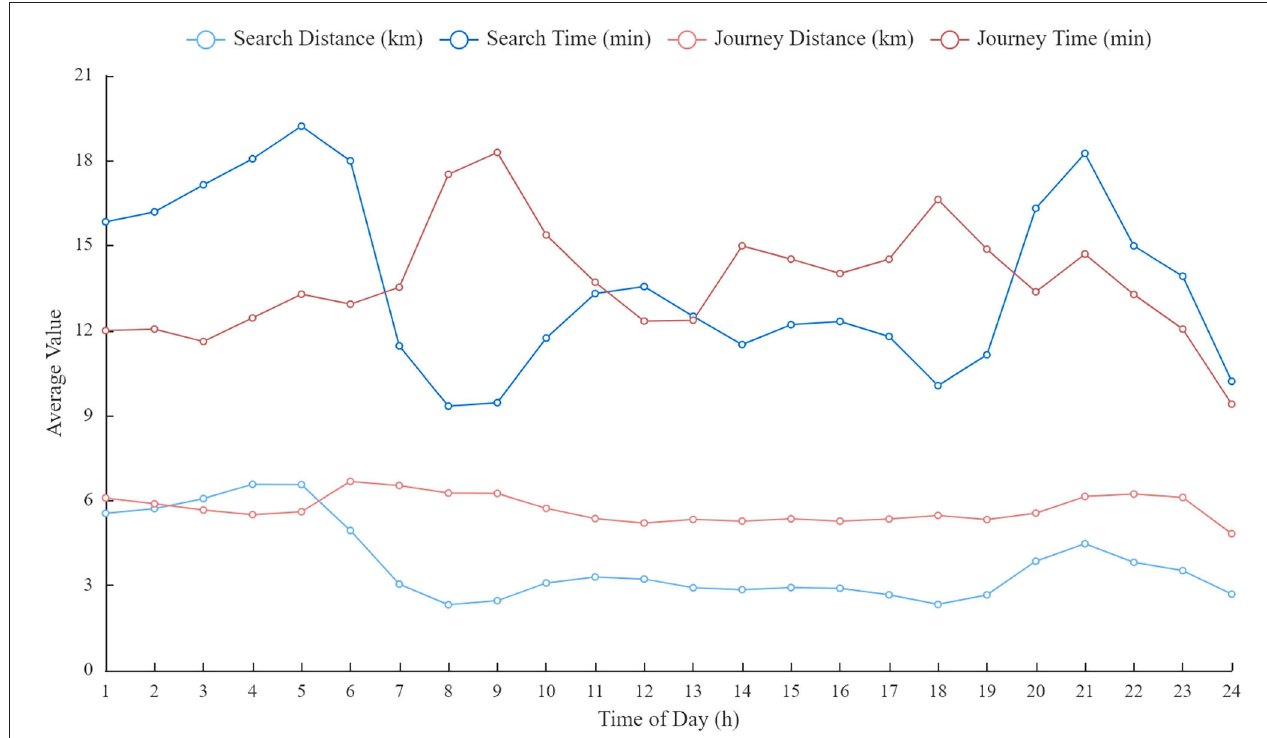
FIGURE 5 | The distribution of trip characteristics on the time of a typical